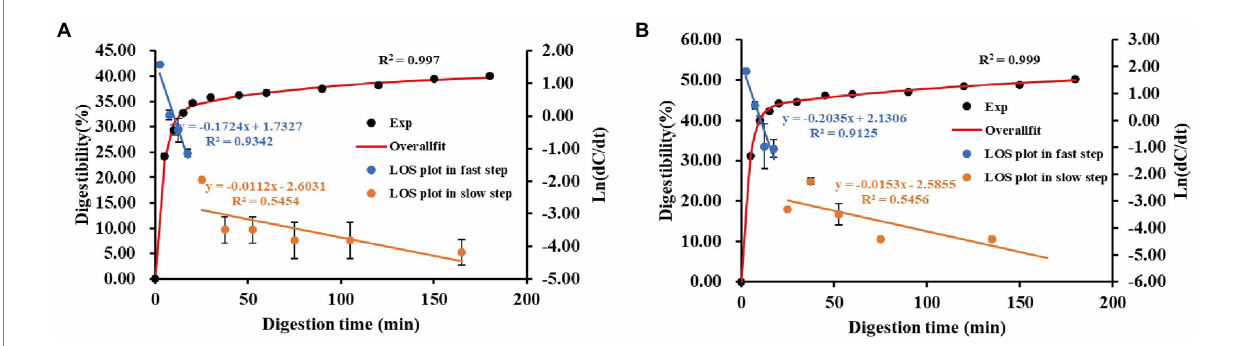
FIGURE 5 Typical starch digestion curves, overall fit curves and LOS plots from different instant powder samples. (A) individual extrusion; (B) mixing extrusion. All of the points in the LOS plots are linearly treated by least-squares fit. All the LOS plots can be divided into two parts with linear lines of different slope: k f and k s represent starch digestion rates for initial fast step and latter slow step, respectively. The R-squared values relate to the LOS plots and overall fit curves. The part of the LOS plot describing k f is shown in blue, and the part describing k s is shown in orange. Digestion data are shown in black points and overallfit curves in a red solid line.